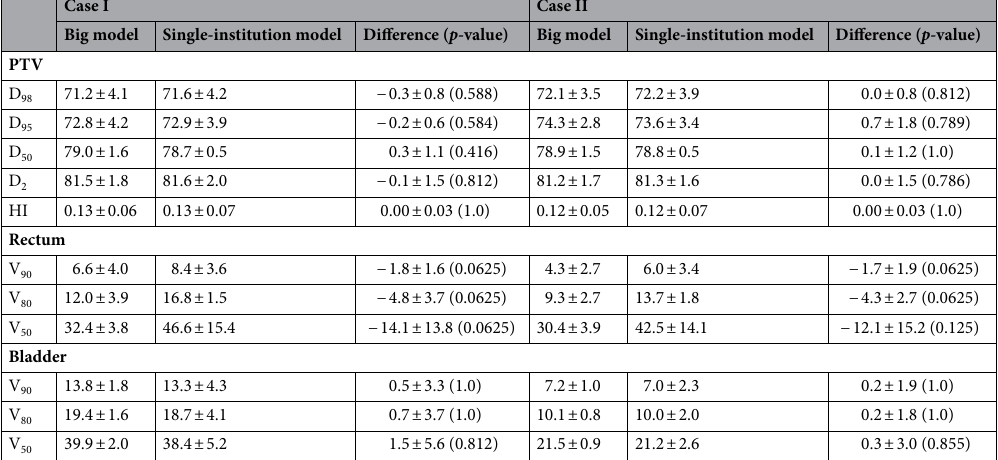
Model analytics. Table 4 shows R 2 and χ 2 values of regression models in each model. The R 2 value cal- culated from regression lines between PCSs of DVH and GEDVH for the big model was comparable to those from each model. The χ 2 value for the big model was the closest to 1.0 compared with each single-institution model. Table 5 shows the ratio and number of outliers for each index, such as CD > 4.0 17 , mZ > 3.5, SR > 3.0, and dA > 3.0 18 , for the rectum and bladder in the training data for each model. The ratio and number of outliers in